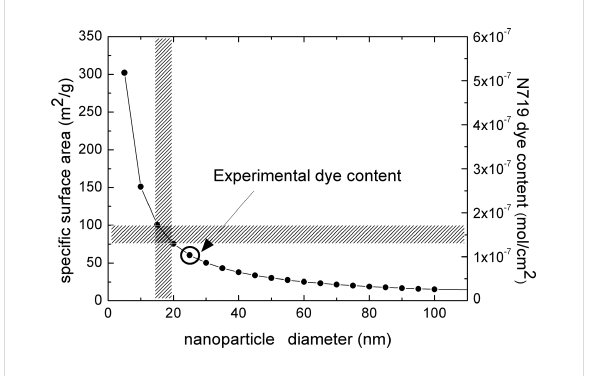
Figure 4: Specific surface area and N719 dye load of the model PA as a function of the nanoparticle diameter. The shadowed region charac- terizes the uncertainty in the diameter of the nanoparticles in the titania paste used in this work, and the consequent uncertainty on the specific surface area and N719 dye content. The experimental value of the dye load, obtained as reported in the text, is also